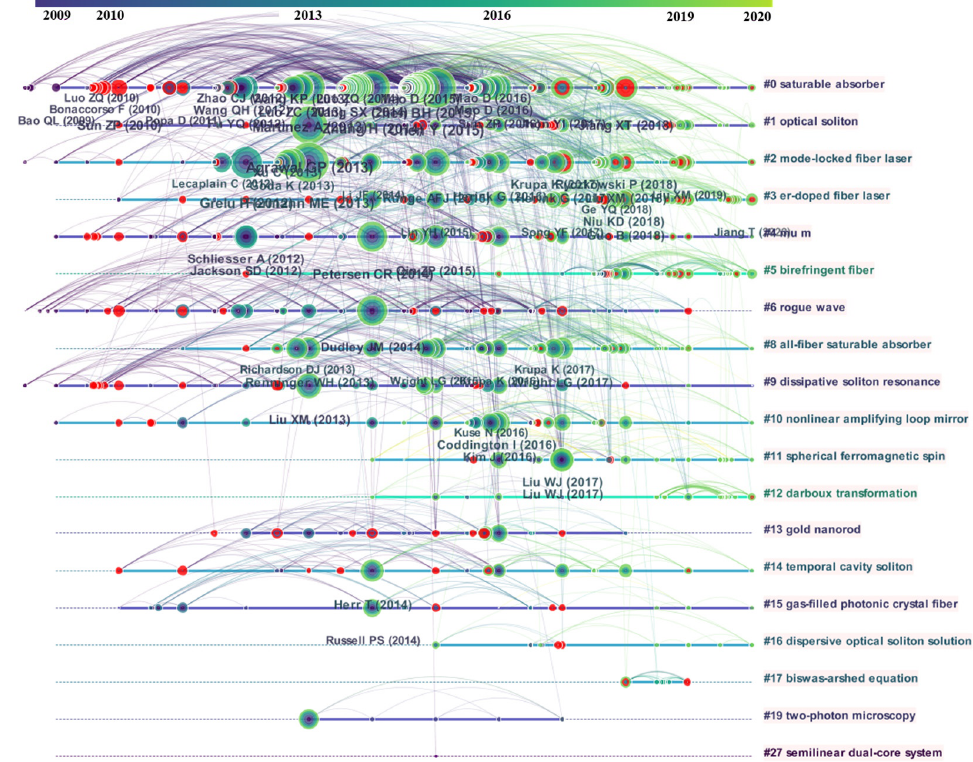
Figure 2. Timeline view of the co-citation network. In the timeline view, each node represents a paper, the size of the nodes represents the size of the number of citations of the paper, the color of the network nodes and the horizontal line from dark to light represent the evolution of the paper’s citation time from early to recent. It should be noted that the red node indicates that it is a burst literature, which plays an important role in this research field. The time of the literature is placed at the top of the view, and the further to the right, the more recent the literature is. In the timeline view, the same clusters of literature are placed on the same horizontal line. The timeline view provides a clear picture of the number of documents in each cluster and the temporal width of the study. More literature in a cluster means the resulting cluster area is more important, and a larger time span reflects a cluster having lasted longer. In addition, the comparison of the time span of the various types of literature on the timeline also allows for an analysis of the rise, boom, and decline of research in the field over time, and thus a discussion of the timing of scientific research.